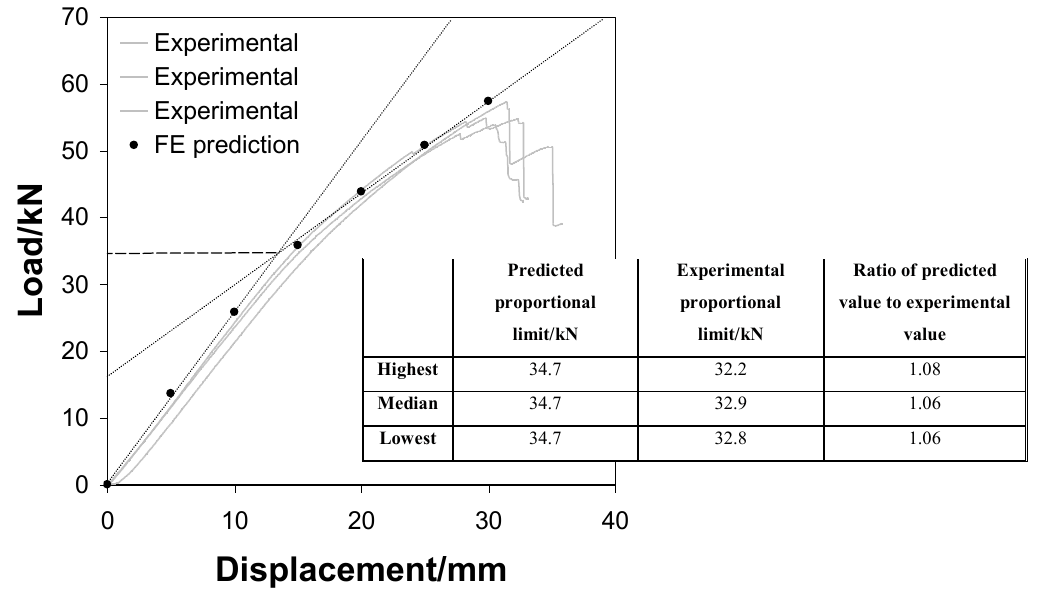
Figure 8. Load-displacement curves for series I tested steel-reinforced LVL samples (in grey) and estimated finite element predictions (black dots). A comparison is made between the predicted and experimental proportional limits.